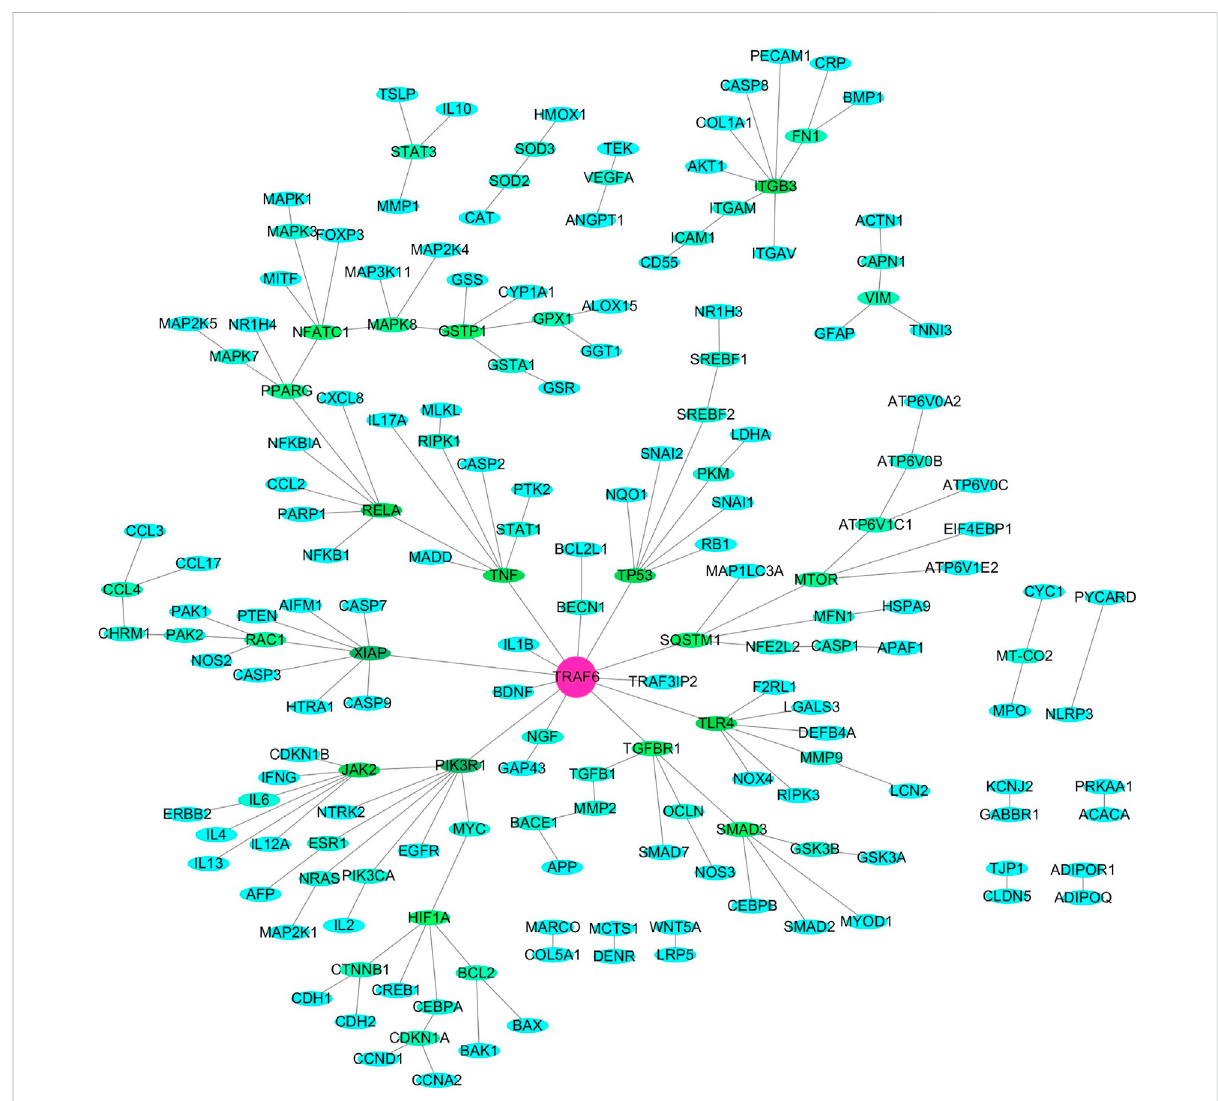
FIGURE 6 PPI analyses (con fi dence:0.4) of proteins and genes reported for BV and its main components in the literature visualized by Cytoscape 3.6.0 software. Texts in purple circle, green circle and light blue circle demonstrates the central hub target, secondary node target and the others node